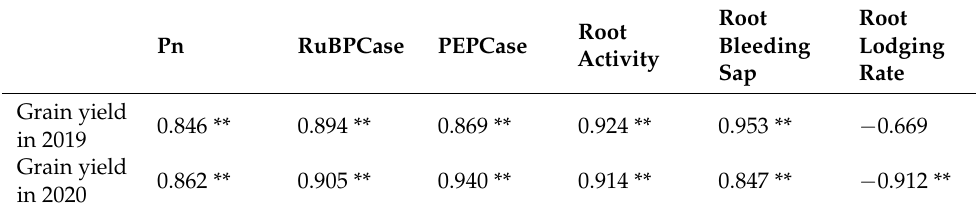
Table 7. Pearson’s correlation coefficients and their statistical significance of grain yield and ear leaf and root